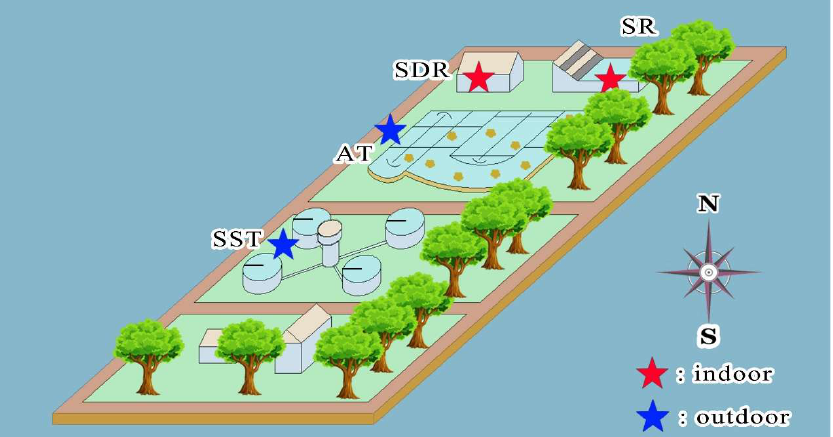
Figure 1. Schematic diagram of sampling sites in the WWTP. AT: aeration tank; SST: secondary settling tank; SDR: sludge dewatering room; and SR: screen room. settling tank; SDR: sludge dewatering room; and SR: screen